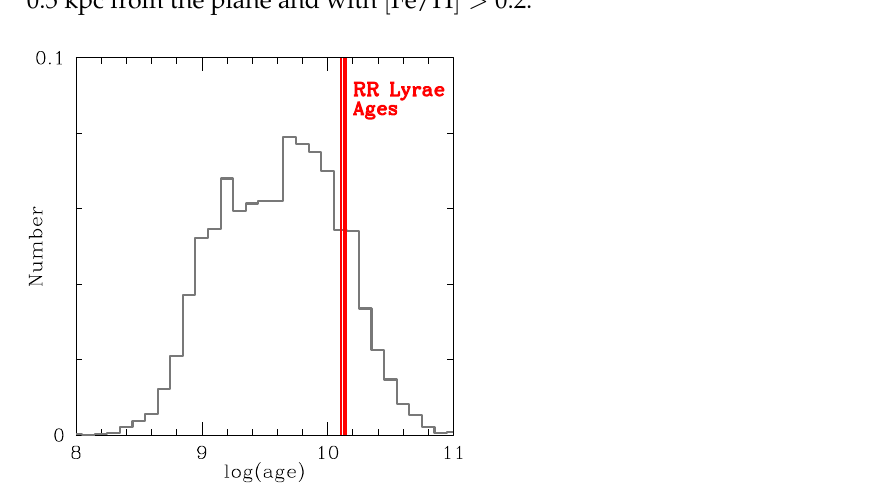
Figure 2. Age distributions of the bulge field stars as compared to the ages of bulge RR Lyrae